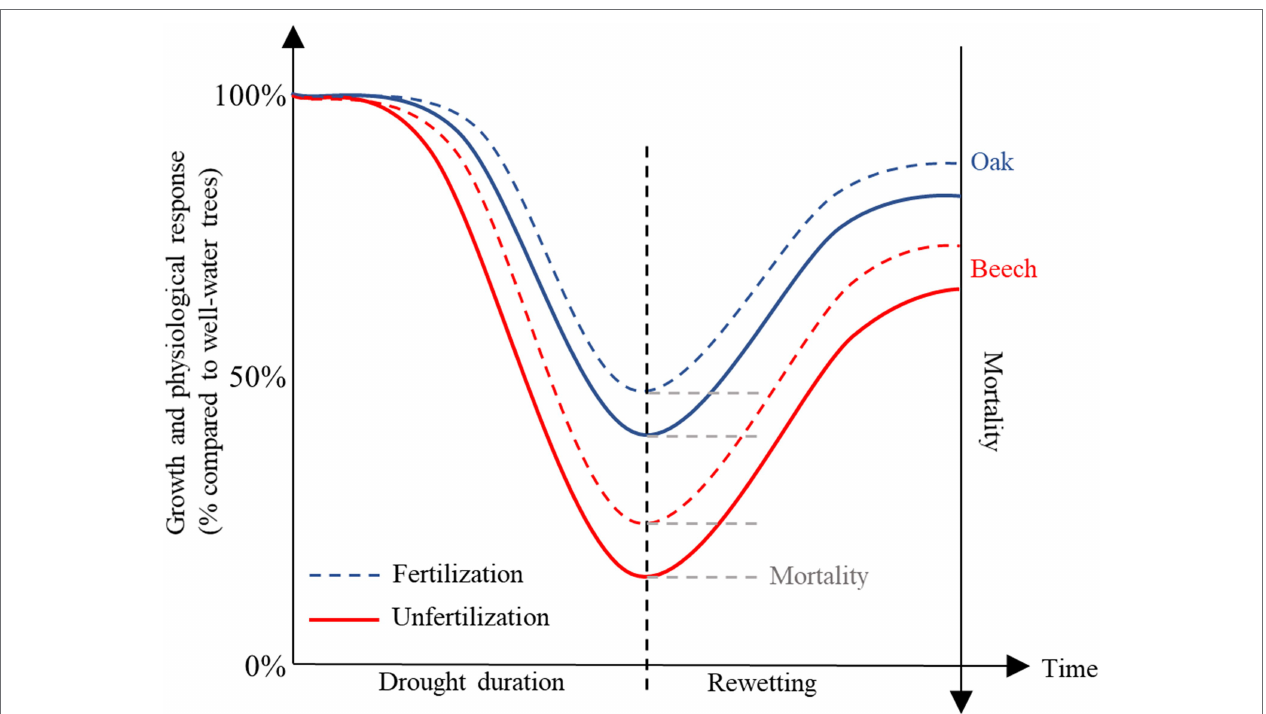
FIGURE 1 | A conceptual model proposed to describe the physiological, growth, mortality, and recovery responses of Quercus petraea (oak) and Fagus sylvatica (beech) to increasing drought duration in combination with fertilization and after drought